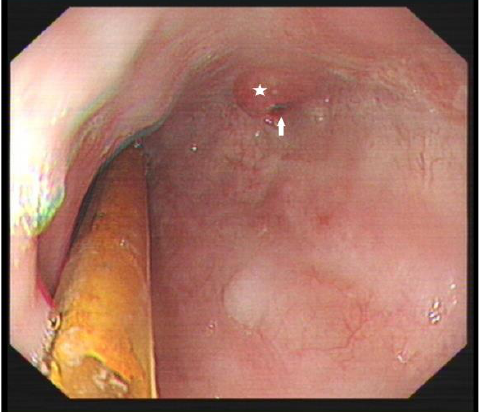
Figure 3. ( a ) Upper gastrointestinal endoscopy showing the opening of the esophageal diverticulum 35 cm from the incisors, in which a large amount of necrosis was observed. ( b ) Upper gastrointestinal endoscopy showing a smooth esophageal wall connected to the esophageal diverticulum.